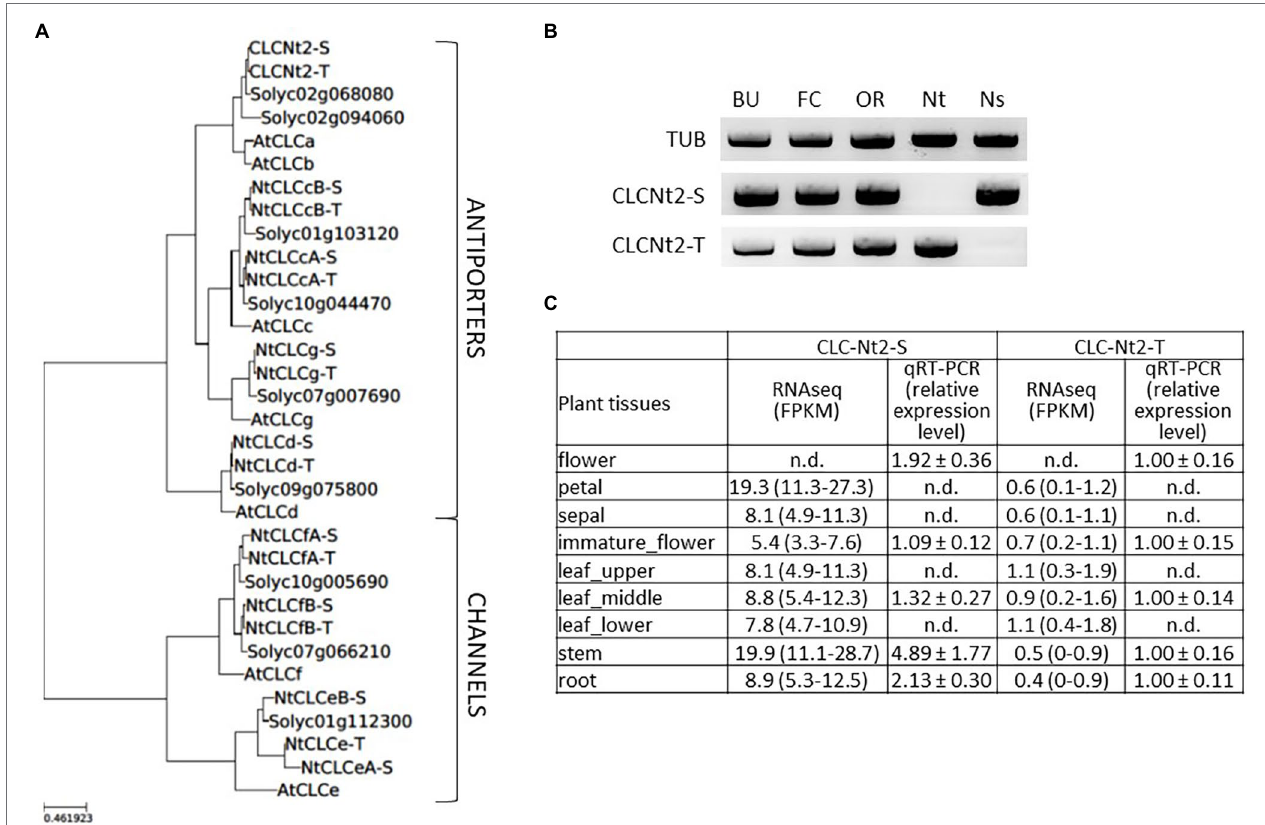
FIGURE 2 | (A) Phylogenetic tree of NtCLCs (17 gene products) including the corresponding chloride channel (CLC) orthologs of Solanum lycopersicum (nine gene products) and Arabidopsis thaliana (seven gene products). The family of NtCLC proteins comprises both chloride/proton antiporters (Cl − /H + ; 10 gene products) and CLCs (Cl − ; seven gene products). Gene product annotation: AtCLCa (AT5G40890); AtCLCb (AT3G27170); AtCLCc (AT5G49890); AtCLCd (AT5G26240); AtCLCe (AT4G35440); AtCLCf (AT1G55620); AtCLCg (AT5G33280); NtCLCeA-S (Ntab-TN90_AYMY-SS16602:116926-118446); NtCLCeB-S (Ntab-TN90_AYMY- SS16602:130486-145725); NtCLCe-T (Ntab-TN90_AYMY-SS14895:89895-95381); CLCNt2-S (Ntab-TN90_AYMY-SS8473:105857-110645); CLCNt2-T (Ntab- TN90_AYMY-SS15578:189268-193506); NtCLCfB-S (Ntab-TN90_AYMY-SS624: 1786564-1796662); NtCLCfB-T